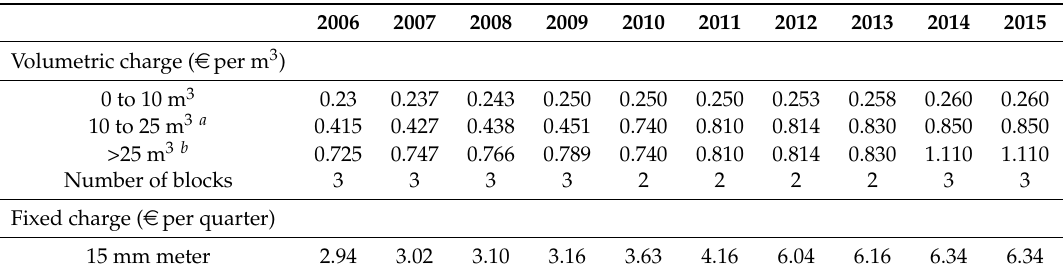
Table 2. Pricing schemes for domestic water use in Andorra La